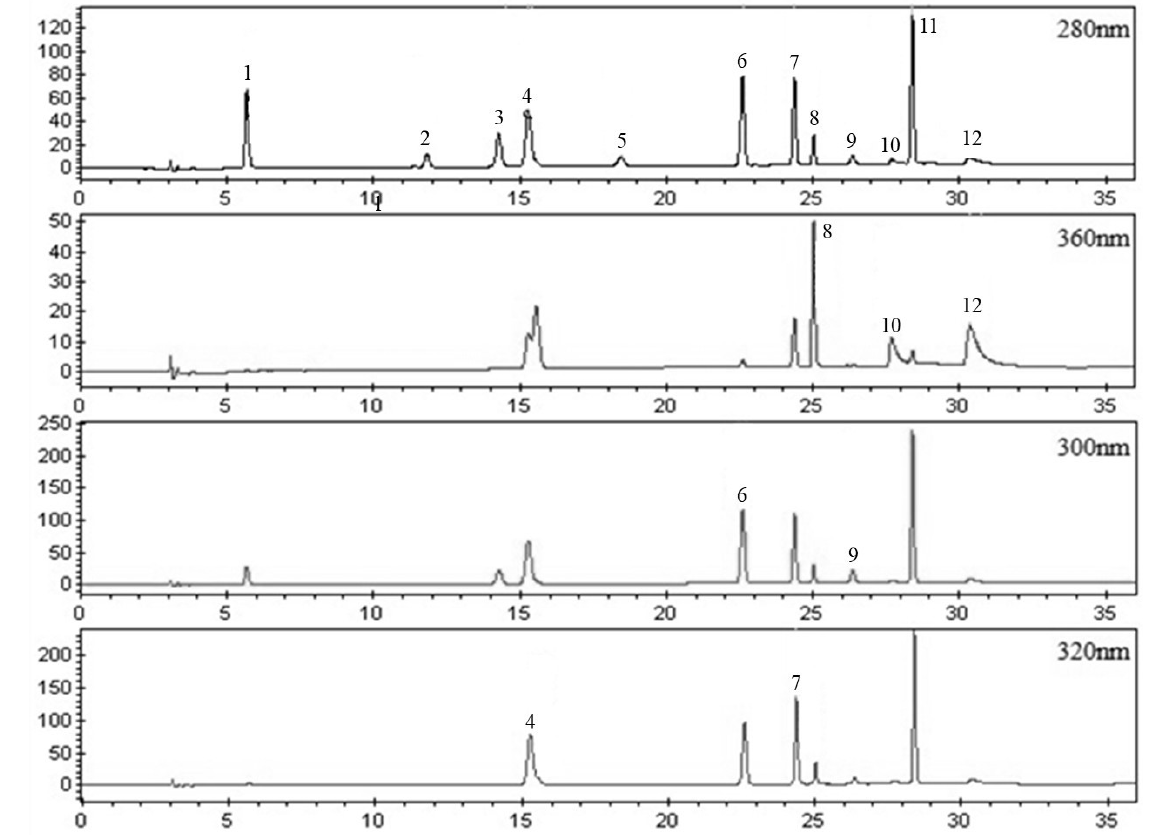
Figure 1. Chromatograms of mixture solvent standard at 30 µg mL -1 in 280, 300, 320 and 360 nm. 1. gallic acid; 2. catechin; 3. vanillic acid; 4. caffeic acid; 5. epicatechin; 6. coumaric acid; 7. ferulic acid; 8. rutin; 9. salicylic acid; 10. myricetin; 11. resveratrol; 12.